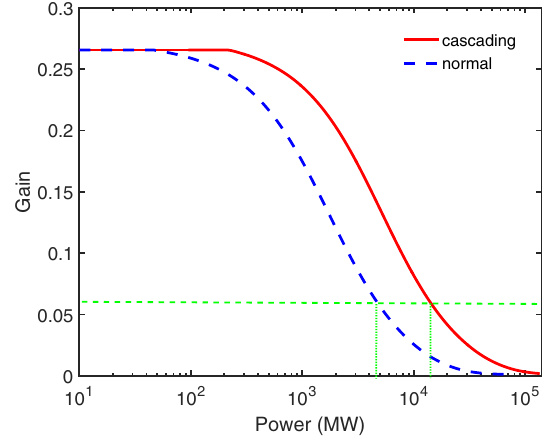
FIG. 2. Single-pass gain as a function of cavity pulse power. The dashed green line represents the single-pass gain at saturation for the typical 6% output coupling. For the same output coupling efficiency, the gain cascading FEL oscillator generates a larger light pulse power inside the cavity than the traditional FEL